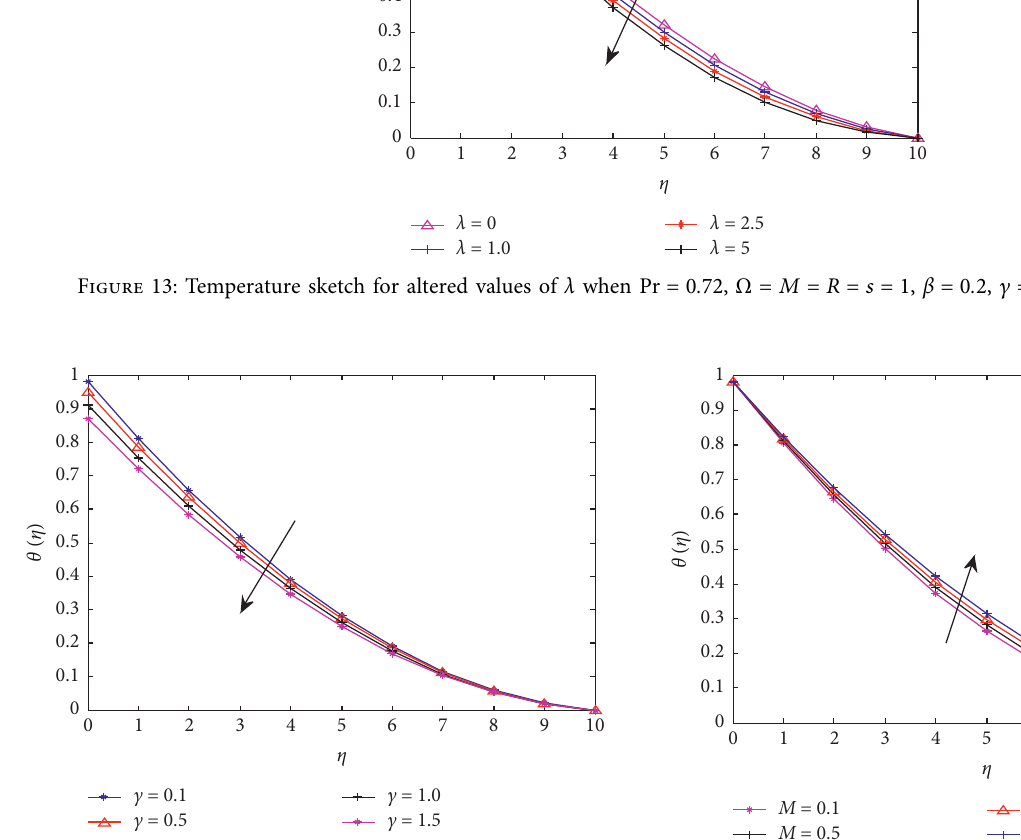
Figure 14: Temperature sketch for various values of c on when Pr � 0 . 72, Ω � M � λ � R � s � 1, β � 0 . 2, and Ec � 0 .